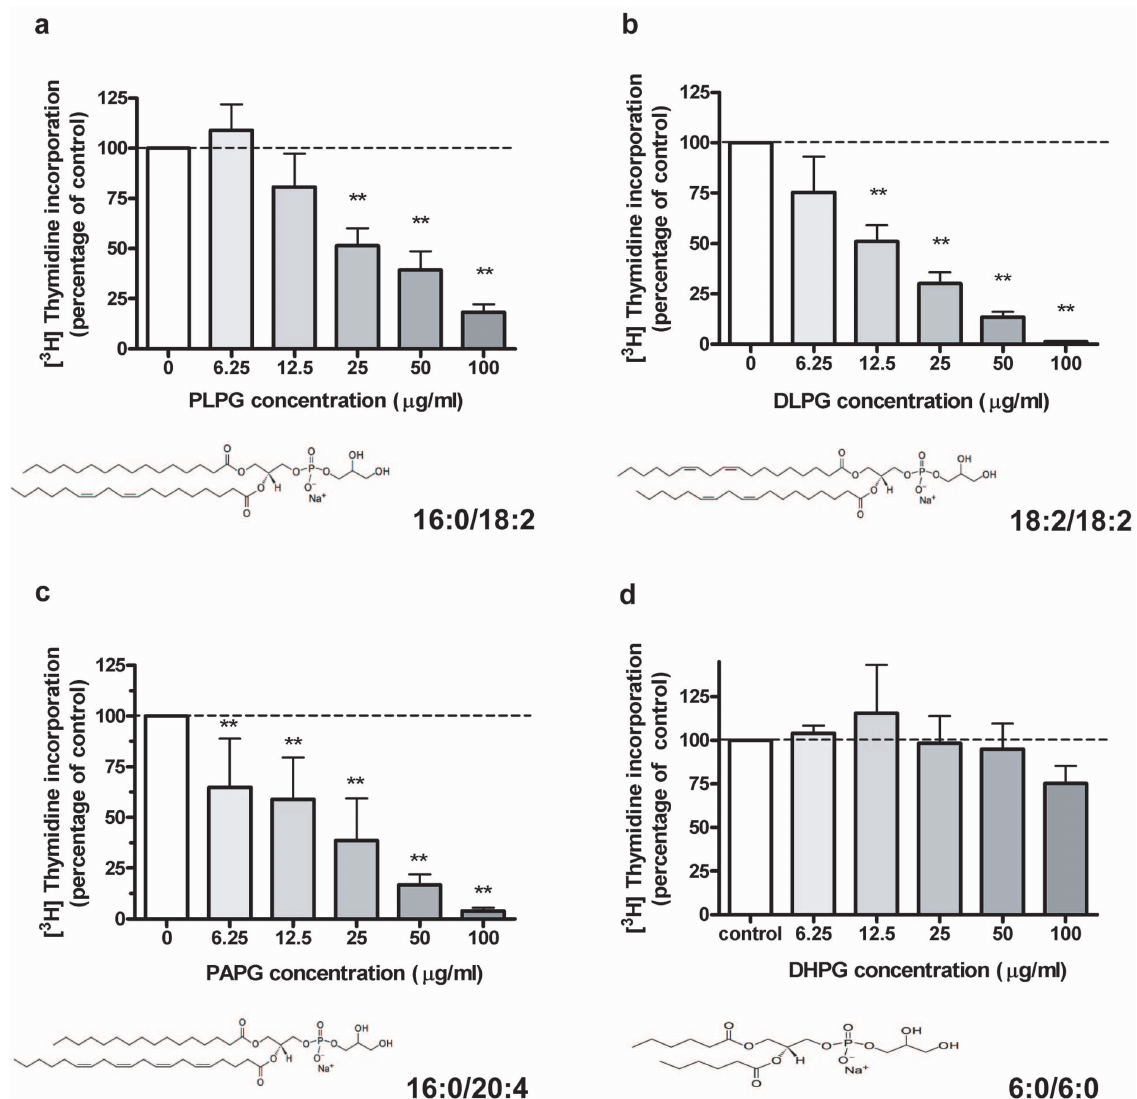
Figure 2. Effects of PG species containing polyunsaturated fatty acids on keratinocyte proliferation. Near-confluent keratinocytes were treated for 24 hrs with the indicated concentrations of liposomes of PLPG (A), DLPG (B), PAPG (C) or DHPG (D), prepared via bath sonication of the different PG species in SFKM. [ 3 H]Thymidine incorporation into DNA was then determined as above. Values represent the means 6 SEM of 3 to 5 separate experiments performed in duplicate; *p , 0.05, **p , 0.01 versus the control value (0 m g/mL level served as control in each